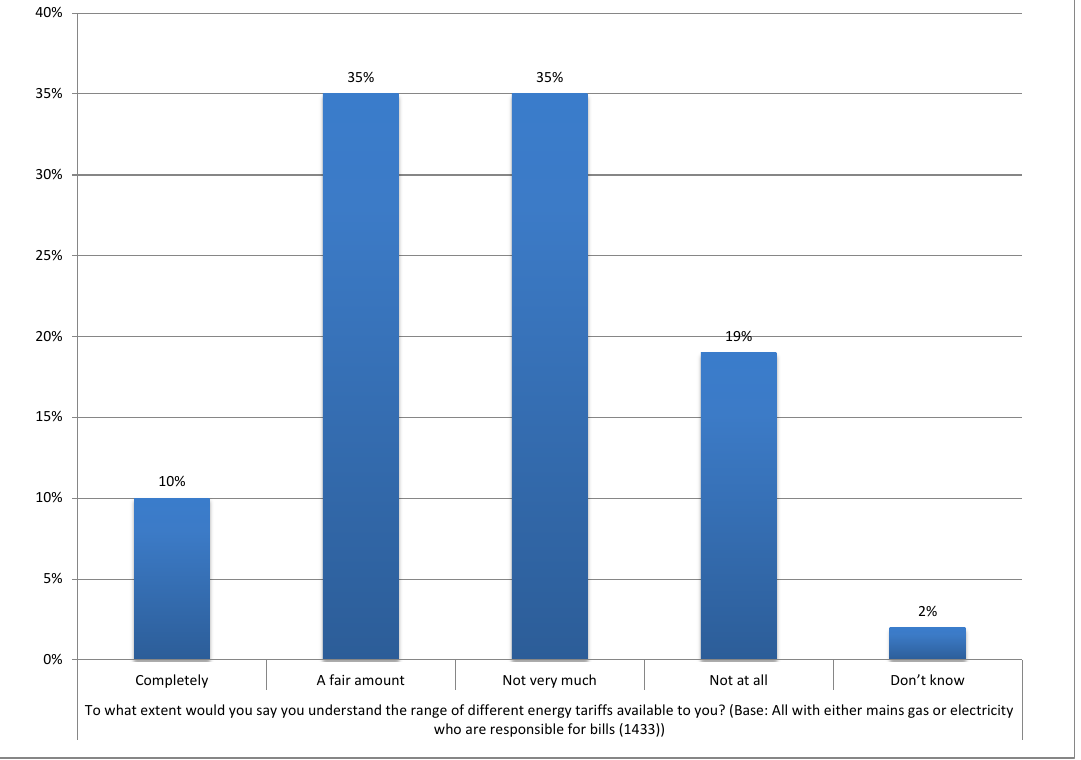
Source: Ipsos MORI, Customer Engagement in the Energy Market - Tracking Survey 2013,